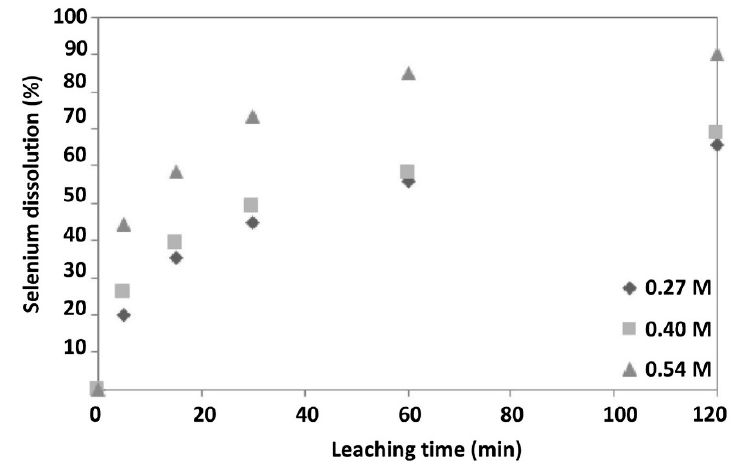
Figure 3. Effect of sodium hypochlorite concentration at pH 11.5 and 45 °C.